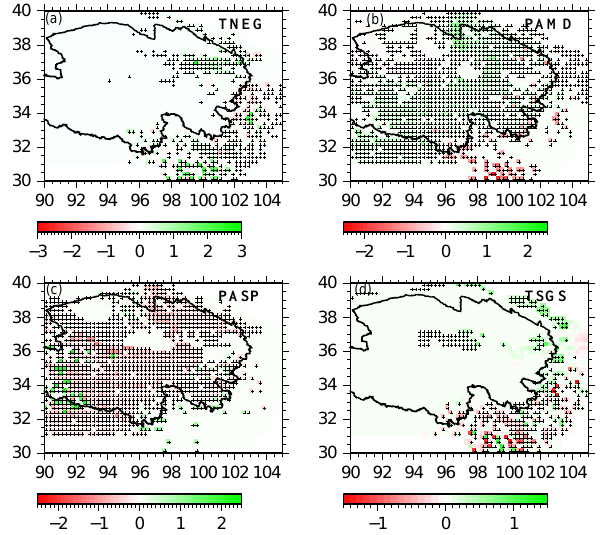
Figure 6. Simulated Mann–Kendall trends of individual FPCs in 1957–2009. TNEG: Temperate needleleaf evergreen, PAMD: perennial alpine meadow, PASP: perennial alpine steppe, TSGS: temperate summer green scrub/grassland. Symbol “ + “ represents statistically significant trends at 95% confidence